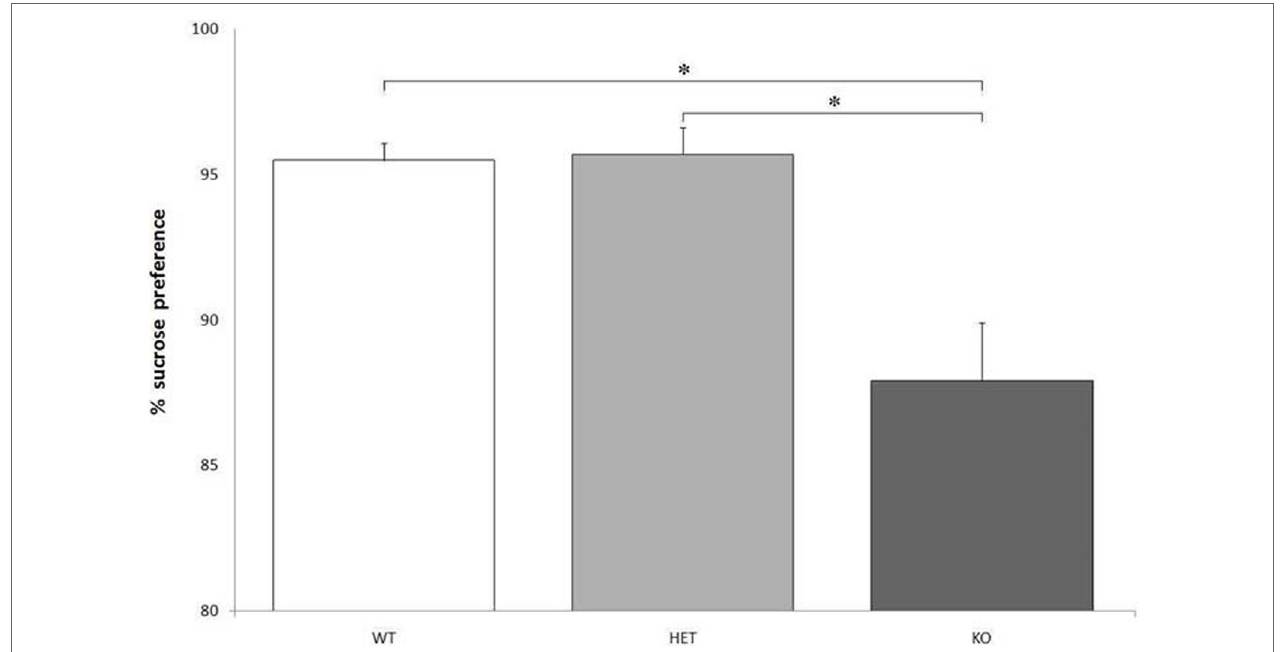
FigUre 2 | Proportion of the fluid intake from a bottle containing 14% sucrose over tap water. Preference for the sucrose bottle is significantly lower for knockout (KO) rats when compared to both wild-type (WT) and dopamine transporter–heterozygous (HET) rats. * P <